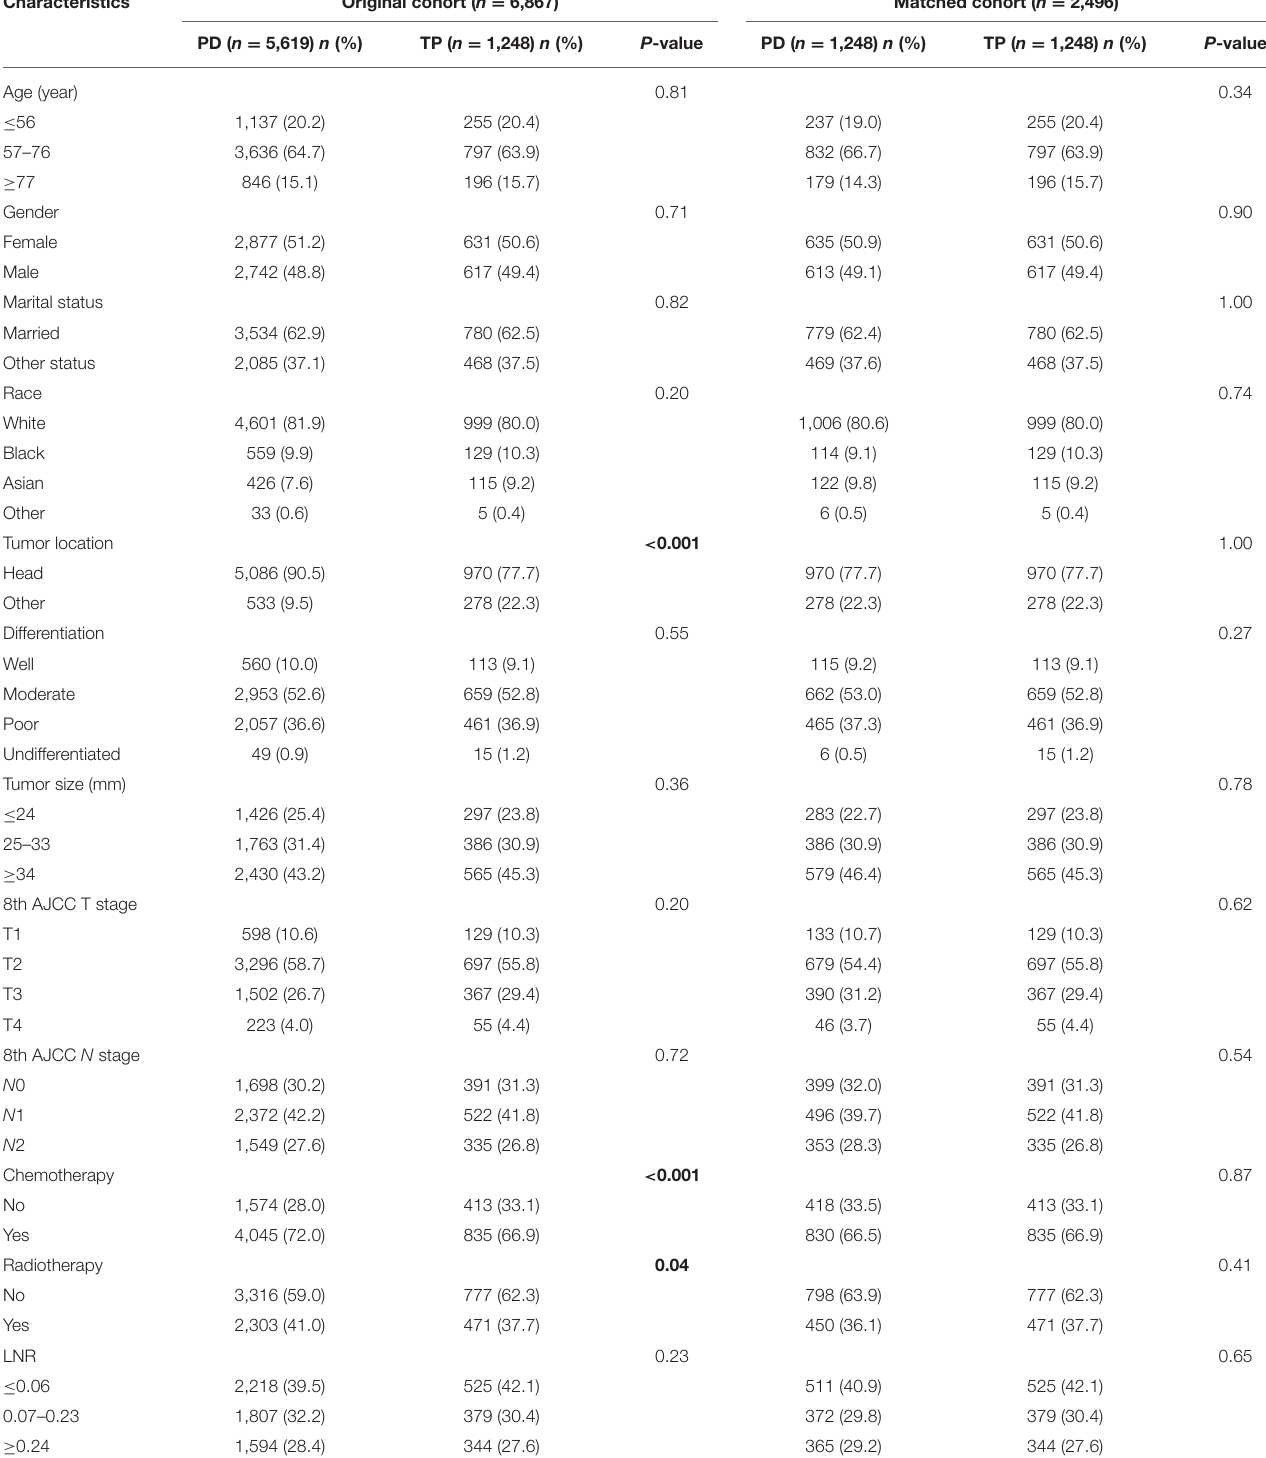
TABLE 1 | Demographic and clinicopathological characteristics of the patients before and after PSM.